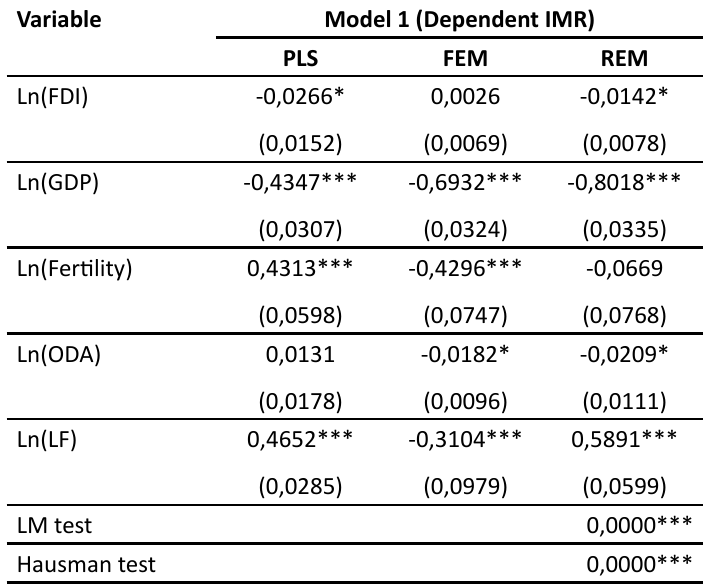
Table 1: Results of Panel Data Regression Estimates with Infant Mortality Rates (IMR)